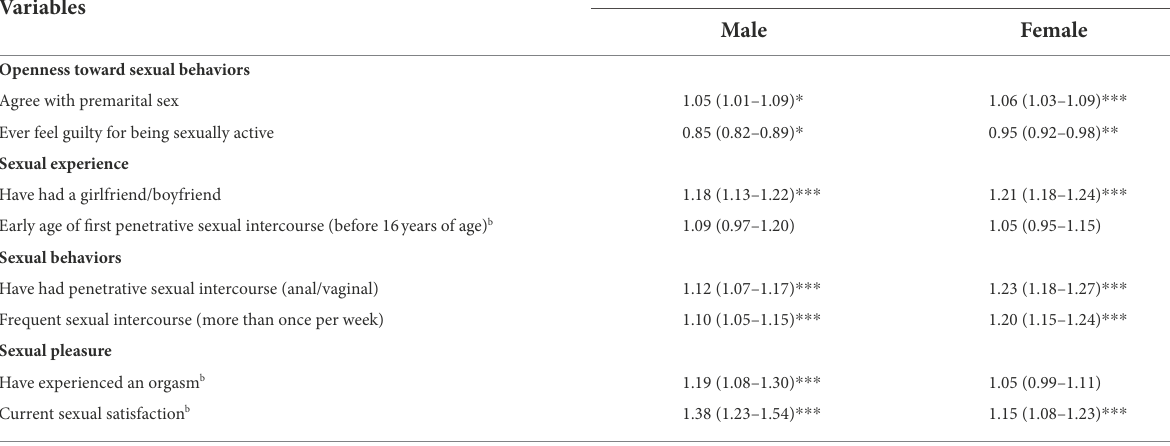
TABLE 2 The association between androgynous tendency and sexual activeness among males and females.